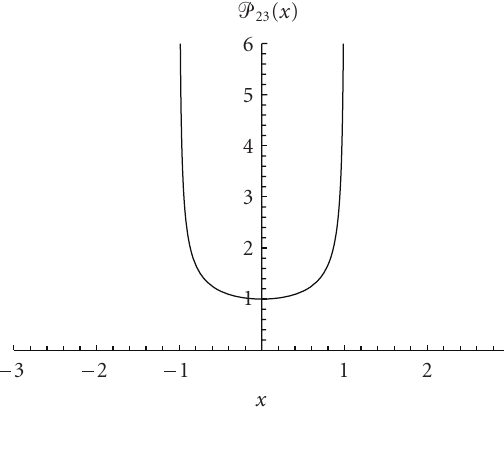
Figure 7.5. The function (cid:2) 23 ( b = 1, κ = 1, b 4 = − 1).